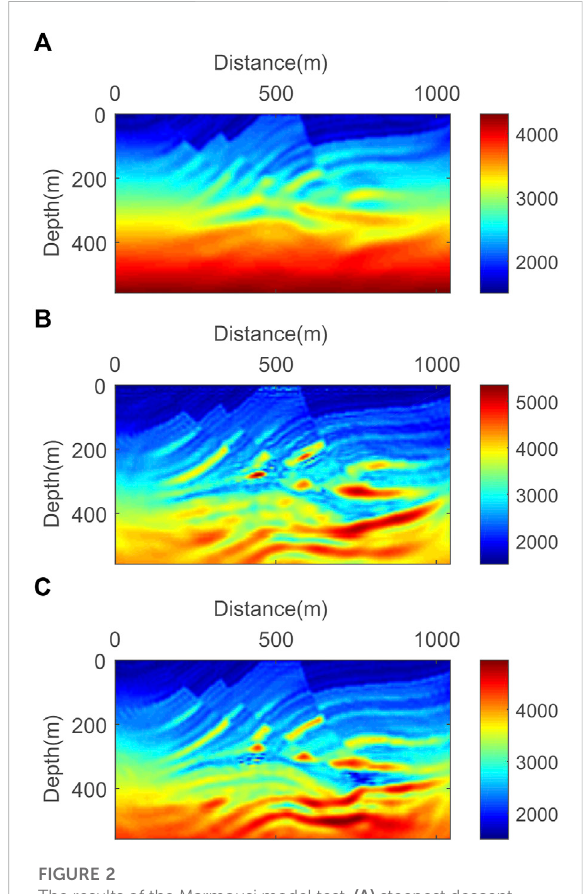
FIGURE 2 The results of the Marmousi model test. (A) steepest descent method, (B) L-BFGS method, (C) mL-BFGS